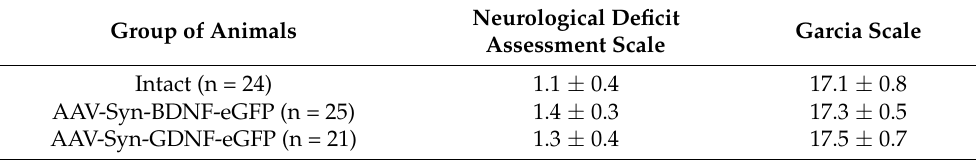
Table 1. Evaluation of neurological status of male C57BL/6 mice 30 days after AAV-Syn-BDNF- eGFP and AAV-Syn-GDNF-eGFP transduction.